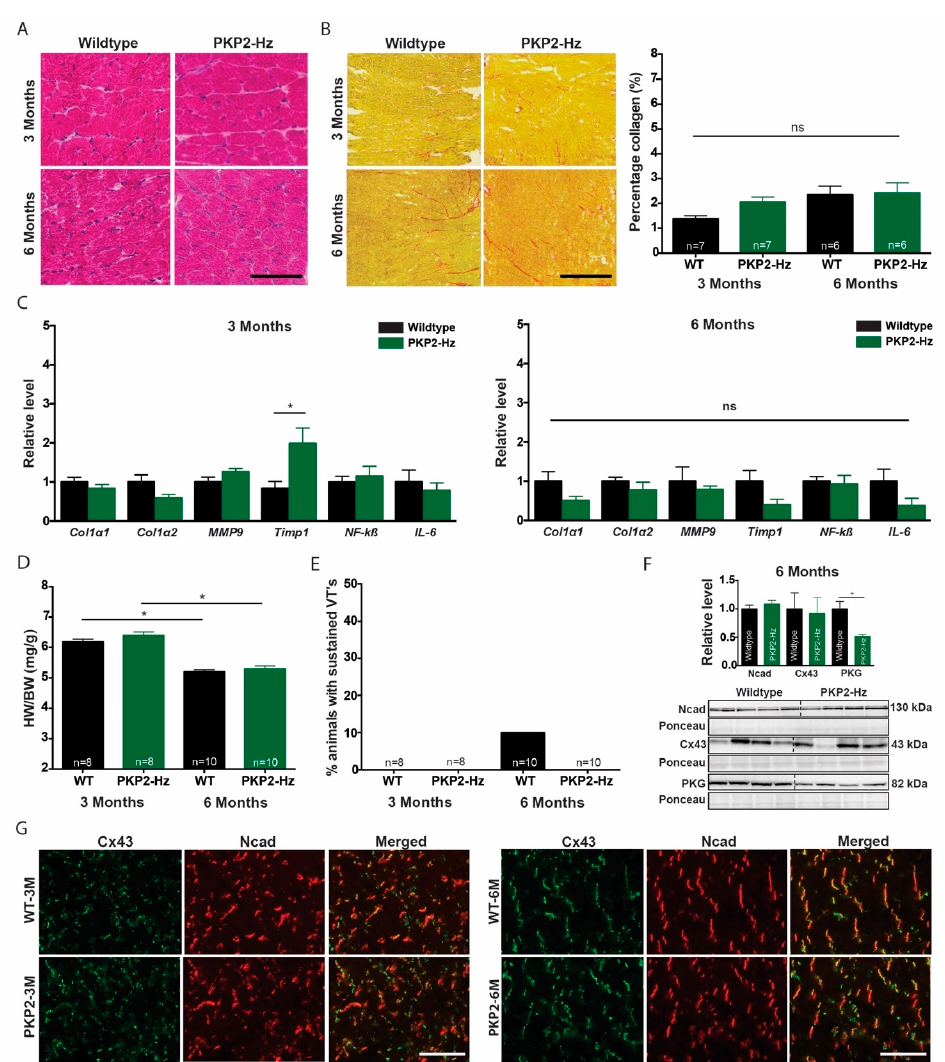
Figure 2. Absence of cardiac remodeling in three and six months old PKP2-Hz mice. ( A ) Hematoxylin and eosin staining of wildtype and PKP2-Hz heart sections, at three and six months of age; scale bar, 100 µm. ( B ) Representative pictures of Picrosirius red staining (left panel) in the inner myocardium of wildtype and PKP2-Hz murine hearts of both ages; scale bar, 500 µm. Quantification of collagen abundance (right panel) in overview slides of whole heart sections (WT 3 months; n = 7, PKP2-Hz three months; n = 7, WT six months; n = 6, PKP2-Hz six months; n = 6, mean ± SEM). ( C ) Relative mRNA expression of Col1 α 1, Col1 α 2, MM9, Timp1, NF- κ ß, and IL-6 assessed by RT-qPCR in three (left) and six month old (right), wildtype and PKP2-Hz ventricular tissue (three months; n = 6 for all groups, six months; n = 4 for all groups, mean ± SEM, * p < 0.05). ( D ) Quantification of heart weight (HW) to body weight (BW) ratio (WT three months; n = 8, PKP2-Hz three months; n = 8, WT six months; n = 10, PKP2-Hz six months; n = 10, mean ± SEM, * p < 0.05). ( E ) Percentage of Langendorf-perfused hearts within each group susceptible for sustained ventricular arrhythmias by epicardial pacing (WT three months; n = 8, PKP2-Hz three months; n = 8, WT six months; n = 10, PKP2-Hz six months; n = 10). ( F ) Representative western blots (bottom) and average densitometry of N-cadherin (Ncad), connexin 43 (Cx43), and plakoglobin (PKG; top, WT; n = 6, PKP2-Hz n = 5 for Cx43 and PKG, WT; n = 4, PKP2-Hz n = 5 for Ncad), measured from wildtype and PKP2-Hz ventricular lysates, six months of age. Upper panels represent western blots, bottom panels according ponceau staining used for quantification (mean ± SEM, * p < 0.05). ( G ) Immunofluorescence staining for Cx43 (green) and Ncad (red) in wildtype (WT) and PKP2-Hz (PKP2) heart sections of three (3M) and six months (6M) of age; Scale bar, 100 µ